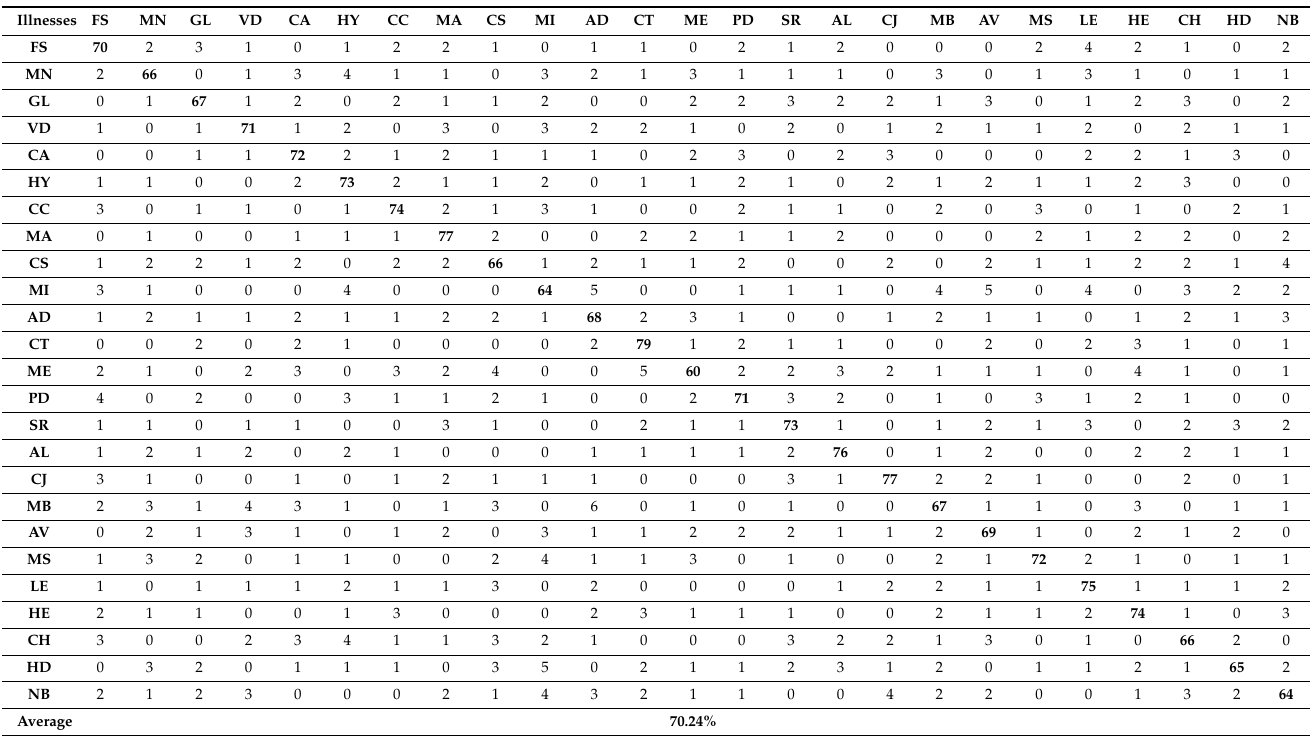
Table 4. Performance of Fusion Feature method (instead of using the developed approach) using MRI dataset (Unit %).